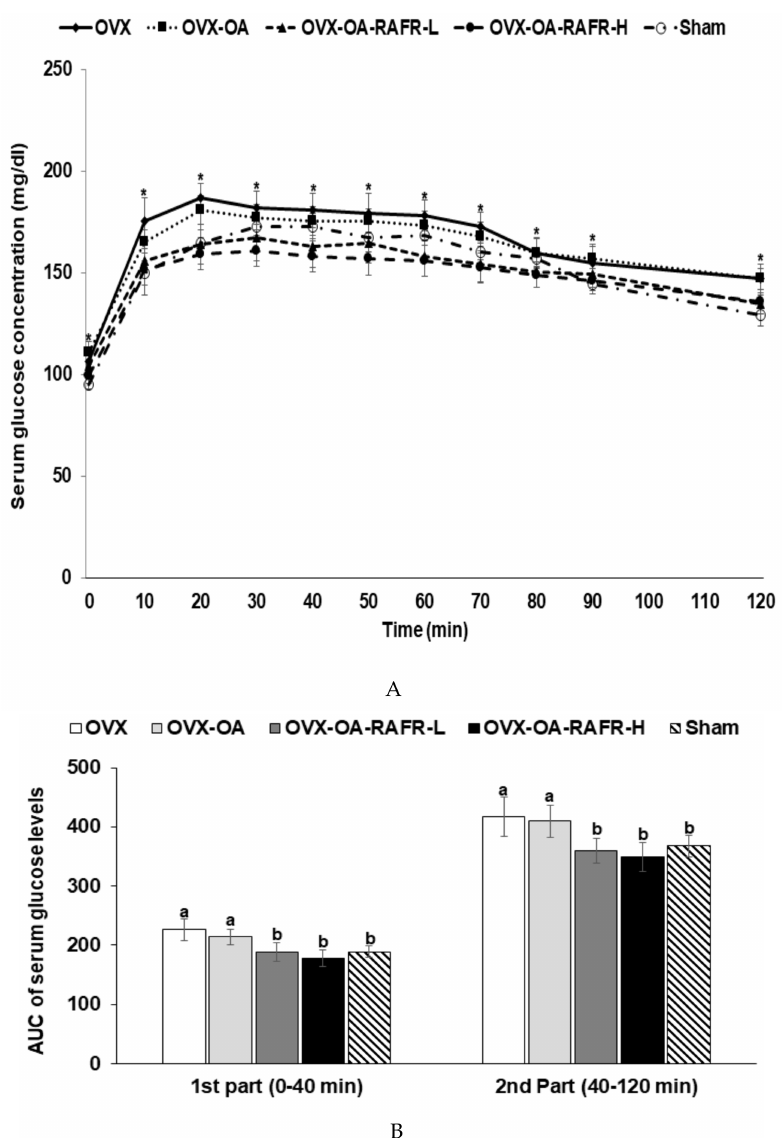
Figure 2. The area under the curve (AUC) of serum glucose concentrations during the oral glucose tolerance test. Ovariectomized (OVX) rats were divided into four groups: (1) MIA injection into the knee joint and fed a high-fat diet containing 0.23% rice + 0.018% AFR diet (RAFR-L). (2) MIA injection into the knee joint and fed a high-fat diet containing 0.69% rice + 0.053% AFR diet (RAFR-H). (3) MIA injection into the knee joint and fed a high-fat diet containing 0.053% cellulose (OA-control). (4) saline injection into the knee joint and fed a high-fat diet containing 0.053% cellulose (non-OA control). Sham rats had the same diet as a control and received a saline injection (normal-control). At the beginning of the eighth week, an articular injection of monoiodoacetate (MIA) into the right knee was performed in all OVX groups except the non-OA control and normal-control groups. Two weeks after the MIA injection, oral glucose tolerance tests were performed with 2 g glucose per kg body weight after 16 h of fasting. Serum glucose ( A ) was measured, and the area under the glucose curve ( B ) was calculated. The dots or bars and error bars represent the mean + SD ( n = 10). a,b Values of the bars with di ff erent superscripts were significantly di ff erent among groups, as per the Tukey test at p <